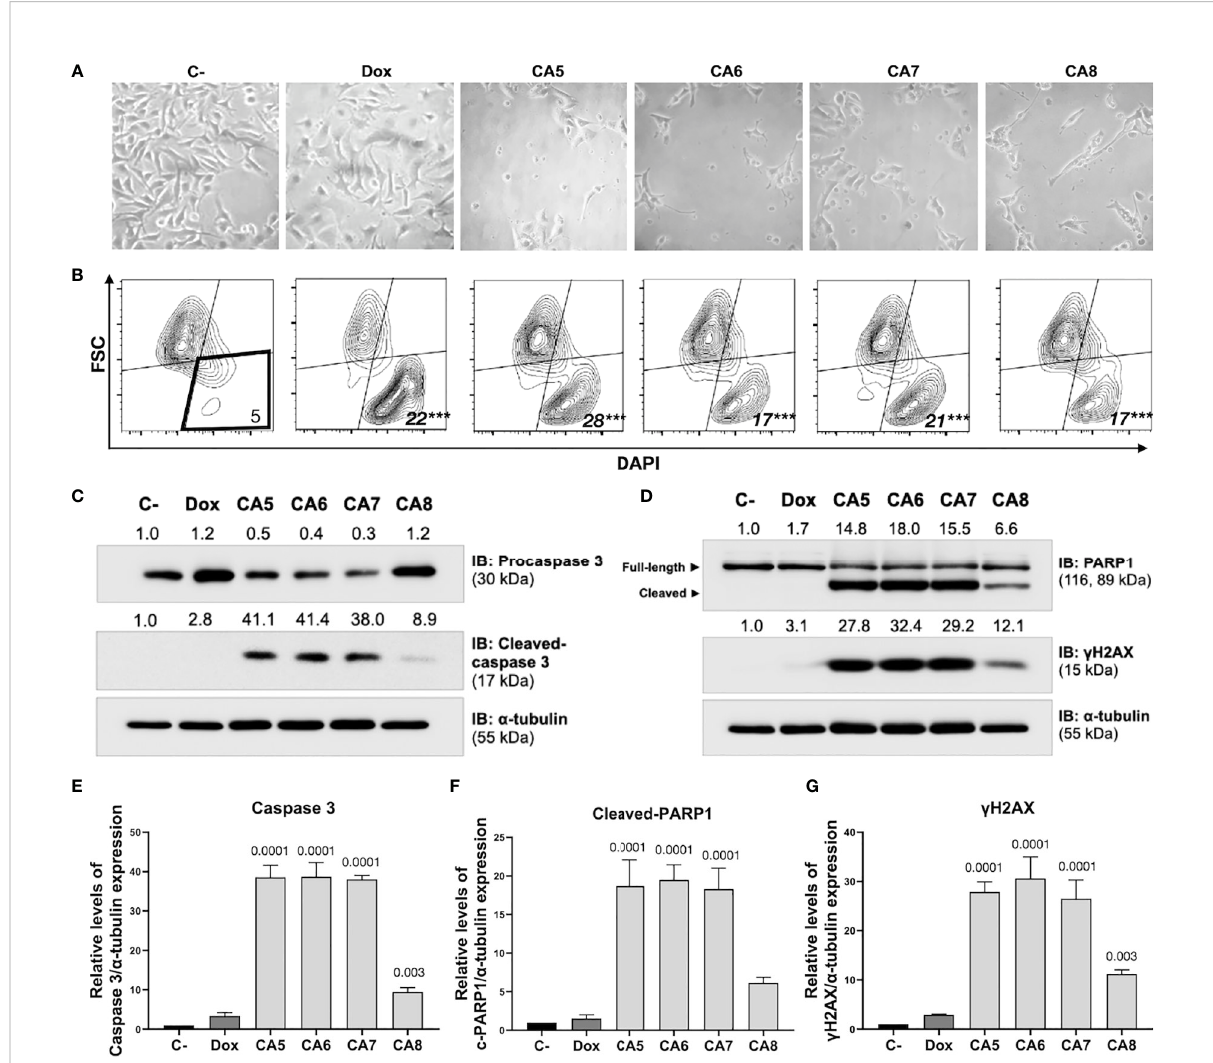
FIGURE 2 Chromomycins A 5-8 induce cellular morphological changes and cell death. B16-F10 melanoma cells were treated with DMSO (C-), as a negative control, doxorubicin (Dox), as a positive control, and CA 5-8 (CA5-8) for 24 h. (A) Phase contrast photomicrographs (200x). (B) Representative contour plot graphs of the cell death subpopulation gated in the low forward scatter (FSC) and DAPI + region by fl ow cytometry. (C) Expression of activated caspase 3 obtained by Western blot. (D) Expression of cleaved PARP1 and g H2AX obtained by Western blot. Values associated with test proteins were normalized to standard a -tubulin for the relative expression measure. (E-G) , column graphs of Western blot analysis. Data presented as mean of 3 independent experiments. Flow cytometry analysis was performed in triplicate. *** p value = 0.001 of treated groups compared to the